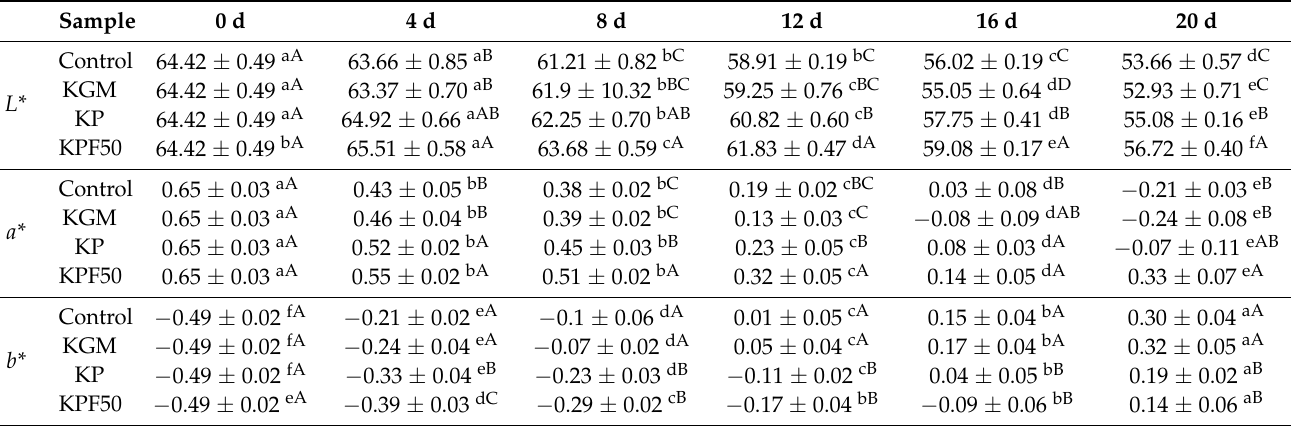
Table 2. Changes in chromatic aberration of sea bass during refrigeration